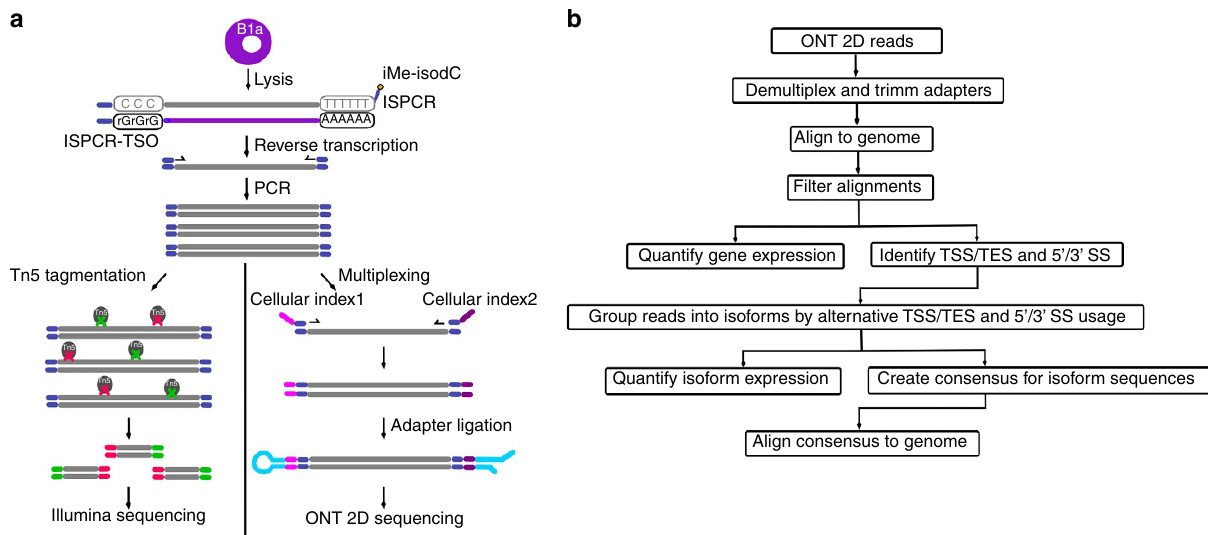
Figure 1 | Experimental design and Oxford Nanopore sequencing read characteristics. ( a ) Schematic of experimental design. FACS-sorted single B1a cells were lysed. PolyA-RNA was then reverse transcribed and PCR amplified using template switching. Full-length cDNA was split into two reactions. Half of the reaction was tagmented by Tn5 and sequenced using a Illumina HiSeq2500 sequencer. The other half of the reaction was ligated to ONTadaptors and sequenced on an ONT MinION sequencer. ( b ) Schematic of the Mandalorion pipeline used to analyse the ONT 2D read data.